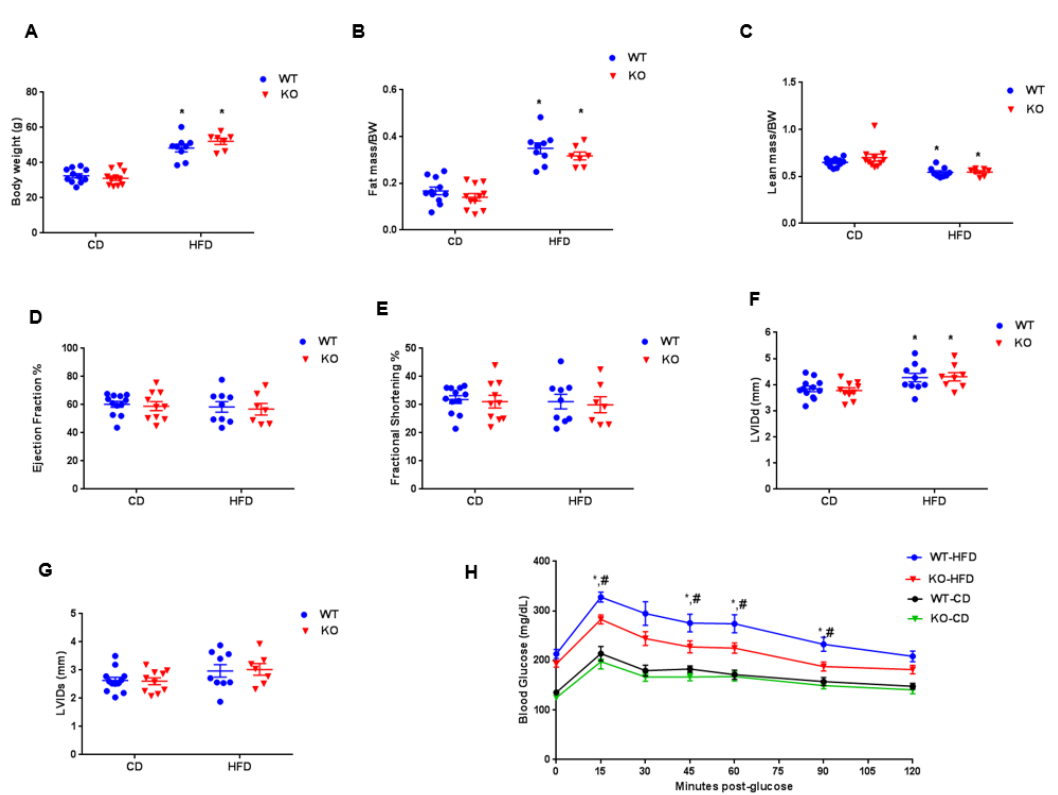
Figure 2. Cardiometabolic phenotyping of WT and CM-GSK-3 β KOs post-HFD. ( A ) Body weights, ( B ) fat mass, ( C ) lean mass, ( D ) left ventricular ejection fraction, ( E ) left ventricular fractional shortening ( F ) left ventricular end-diastolic interior dimension (LVIDd), ( G ) left ventricular end-systolic interior dimension (LVIDs), ( H ) glucose tolerance test (GTT) in WT and KO animals after 55 weeks on CD or HFD ( n = 10–12 per group). * p < 0.05 CD vs. HFD; # p < 0.05 WT vs. KO.